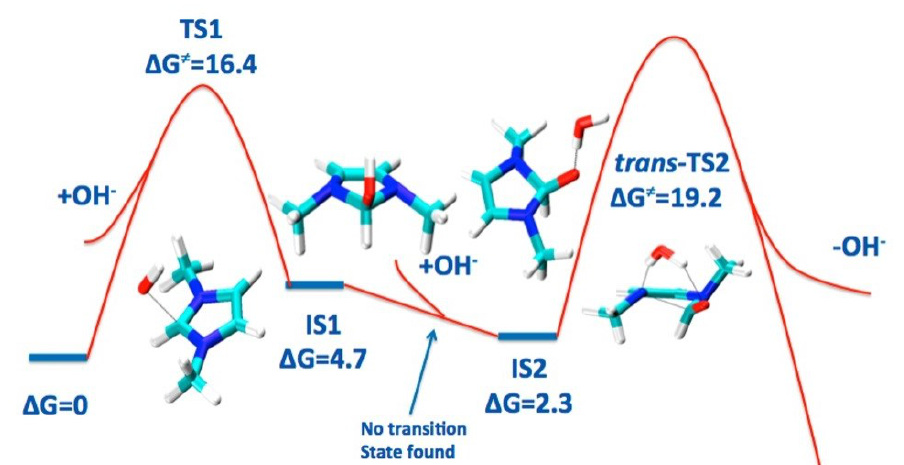
Figure 4. Free energy diagram for the nucleophilic addition–elimination pathway for the benzimidazolium-based head group (unit: kcal/mol). Reprinted, with permission from [110]. Copy- right 2014, for the American Chemical